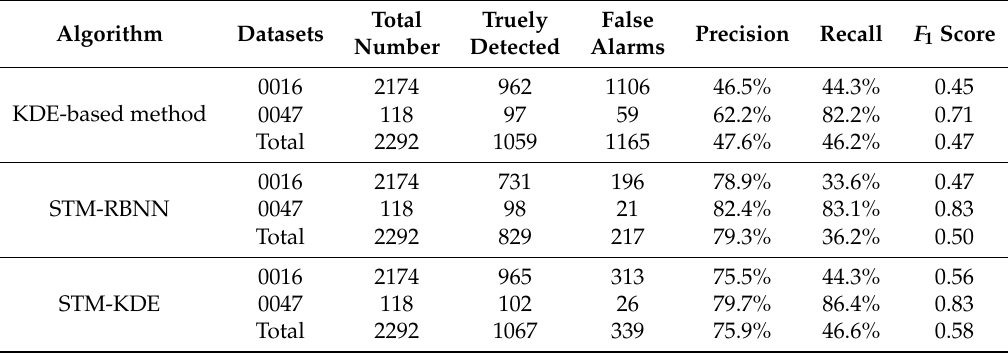
Table 3. Pedestrian detection in the range of 50